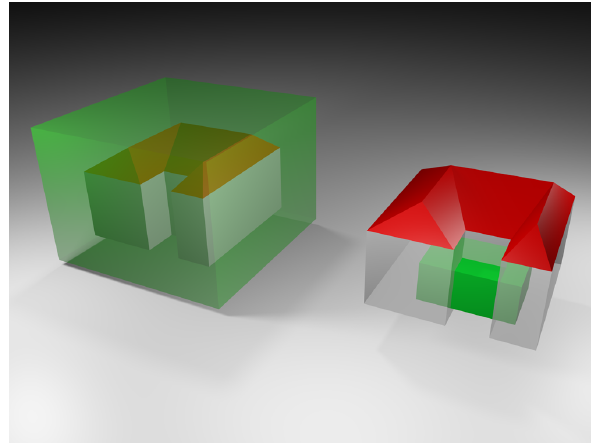
Figure 9: Subdivision strategies for voxels that completely con- tain the building (left building in the figure) and for voxels with all vertices voting for being inside the building (right building of the